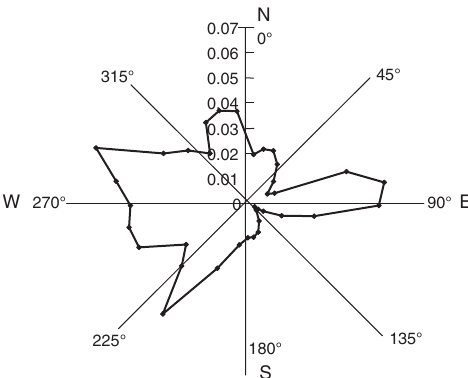
Fig. 5. Distribution of wind directions at 30 m height above ground level during a month in